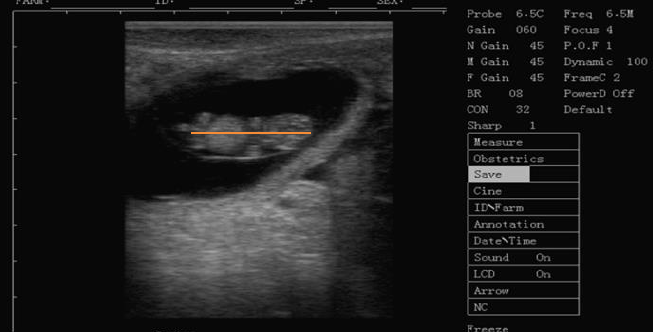
Figure 2. Buffalo embryo on the day 65 shows crown rump length